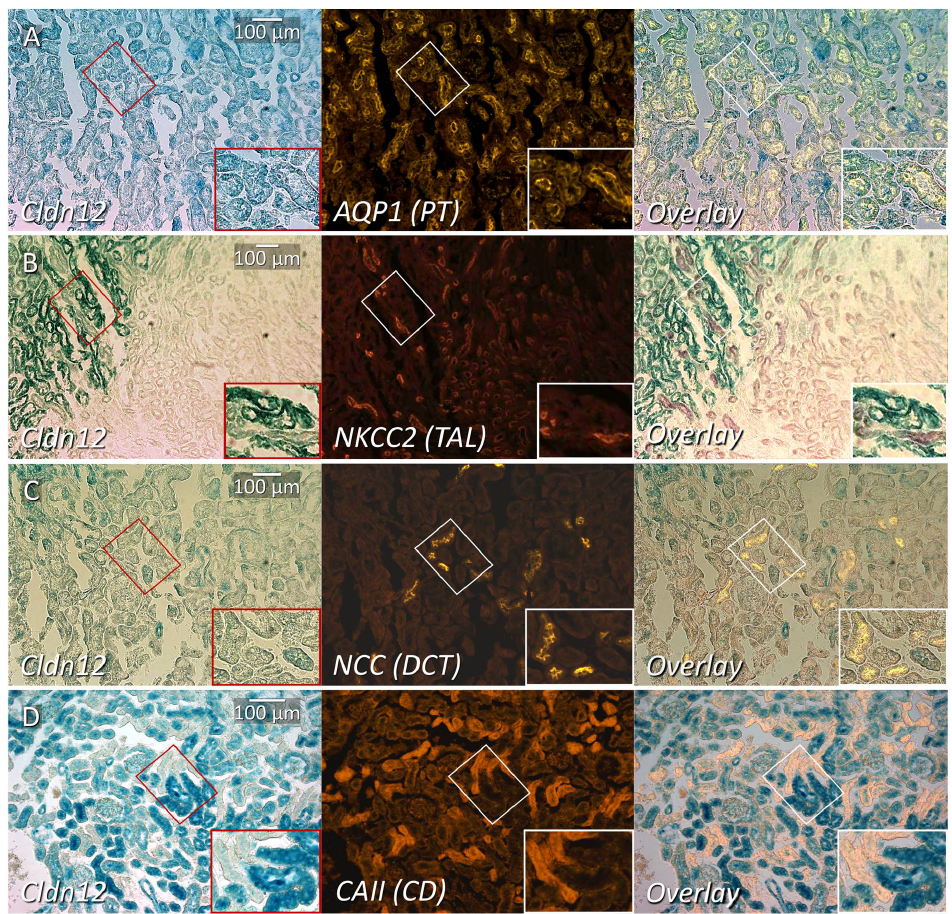
Figure 3. Co-staining of cortical renal tubule markers with X-gal on kidney slices from claudin-12 heterozygous mice. X-gal staining representing claudin-12 promoter expression (Cld12)